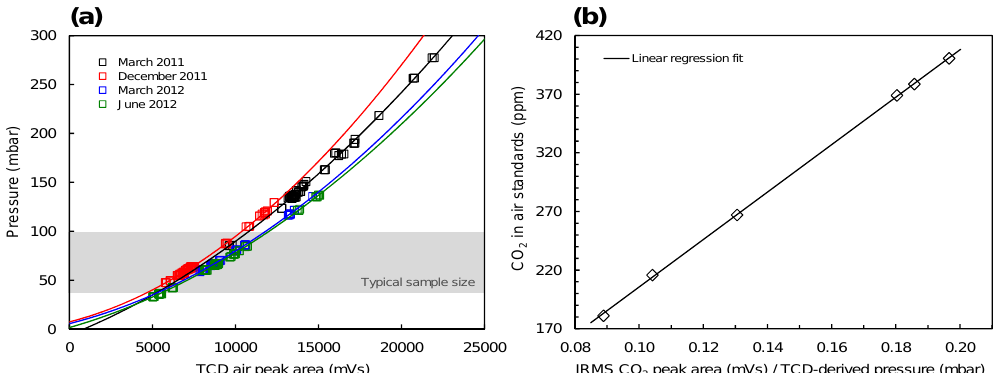
Figure 4. CO 2 calibration. (a) Relationship between sample size and TCD peak area of air for different measurement periods. The lines are second-order polynomial fits through the data. Pressure in the injection volume is proportional to amount. The grey bar indicates the typical sample size range extracted from ice samples. (b) Calibration curve; known CO 2 mixing ratios of air standards vs. ratio of IRMS peak area for CO 2 ( m/z 44) and TCD detected air amount transformed to pressure from the relationship shown in (a)